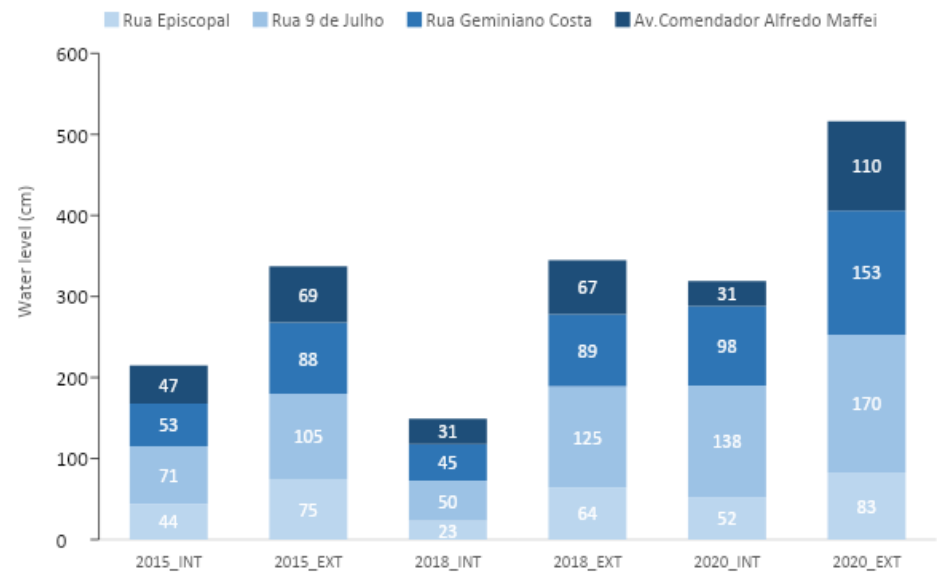
Figure 9. Relation between the water levels inside (INT) and outside (EXT) the properties for the three observed flood events, 2015, 2018 and 2020.